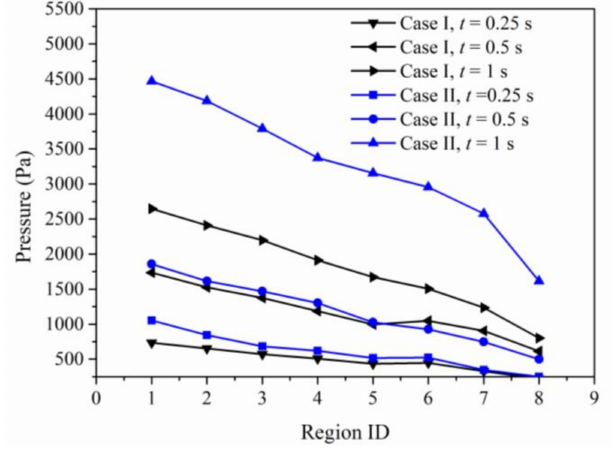
Figure 9. Average pressure distribution along the flow direction (continuous